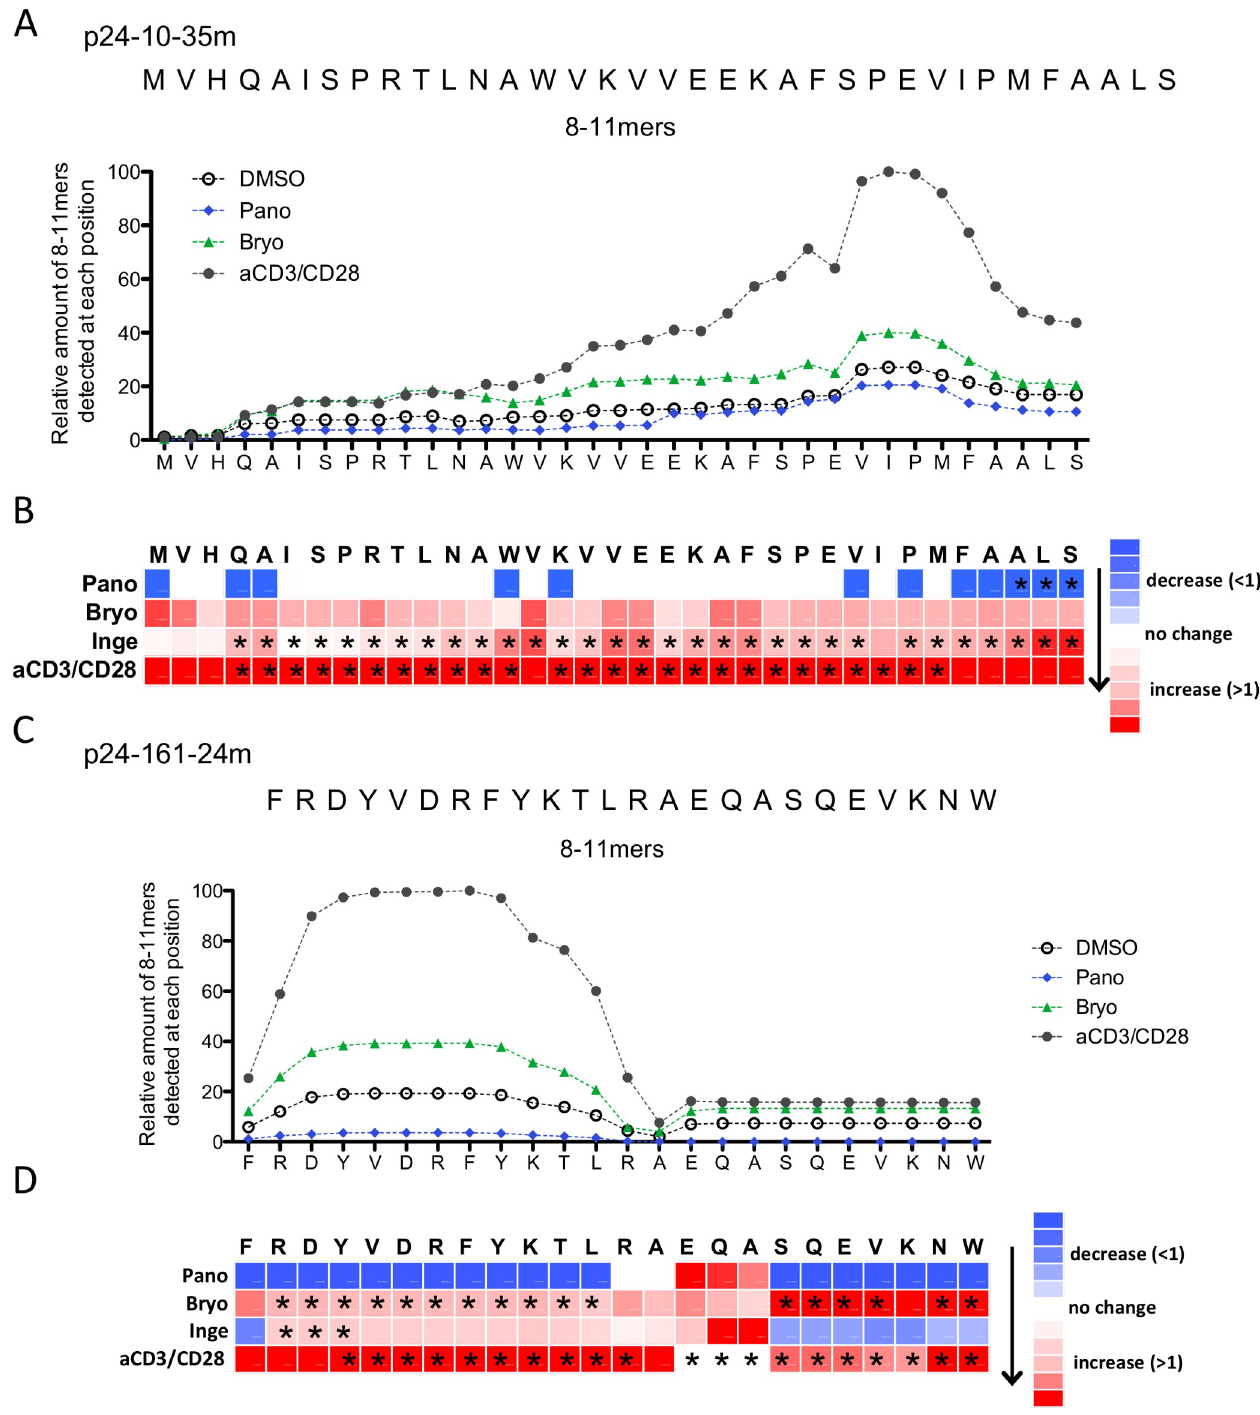
Fig 4. LRA treatments alter the degradation patterns of HIV-1 long peptides into peptides of 8-11aa beyond known HIV epitopes. A. Relative amount of degradation peptides of 8-11aa detected at each residue of p24-10-35m during degradation in CD4 T cell extracts treated with DMSO (open circles), Bryostatin (green), Panobinostat (blue) or aCD3/CD28 (grey). Results shown for a representative experiment. B. Heat map showing the changes in the contribution of each residue to the production of 8-11aa peptides during the degradation of p24-10-35m in Panobinostat, Bryostatin, Ingenol or aCD3/CD28 over matched DMSO control. n = 7–11 donors. Stars show statistically significant changes (p < 0.05). C. Same as A for p24-161-24m degradation peptides. D. Heat map similar to B for p24-161-24mer. n = 4–10 donors.